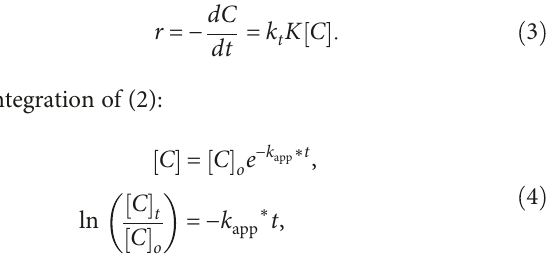
Figure 3: Raman spectrum to TiO composite thin fi